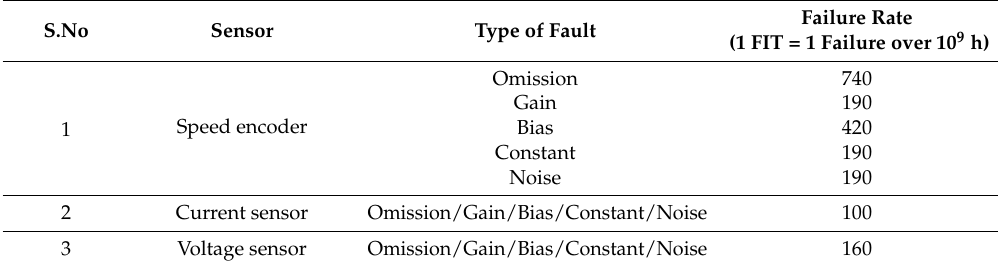
Table 5. Failure rate for sensors [32,34].